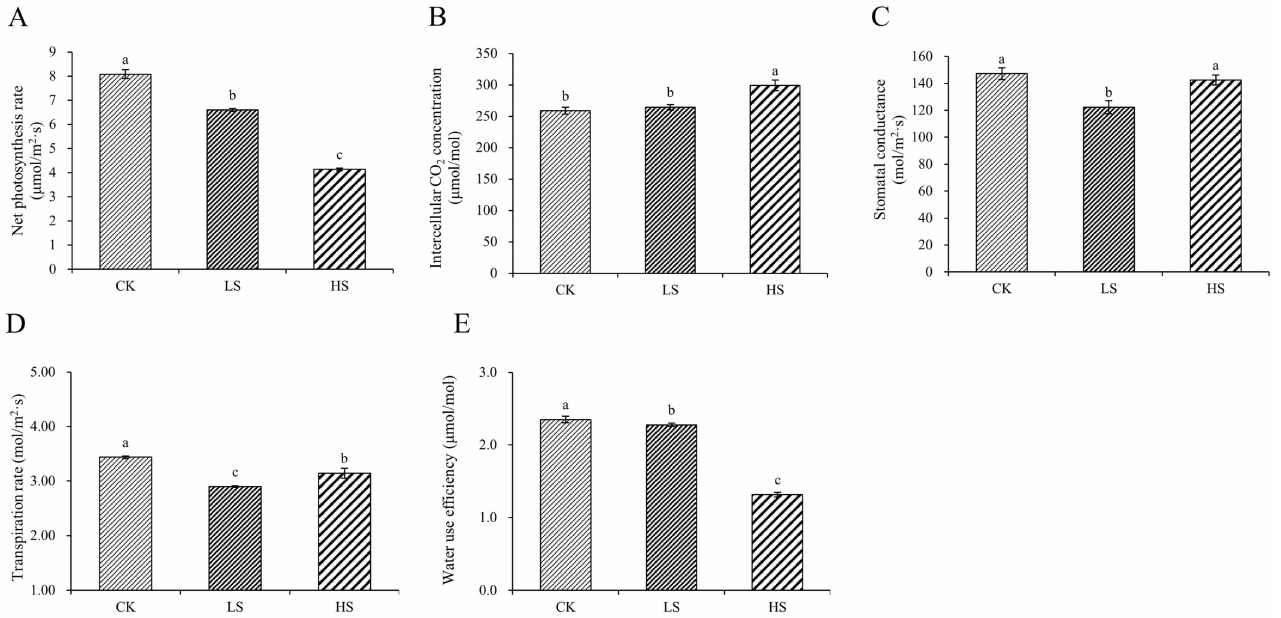
Figure 2. Changes in photosynthetic indicators in P. koraiensis under light stress. ( A ) Net photosyn- thetic rate. ( B ) Intercellular CO 2 concentration. ( C ) Stomatal conductance. ( D ) Transpiration rate. ( E ) Water use efficiency. CK: control. LS: light shade. HS: heavy shade. The error bars represent the standard error. Different letters indicate significant differences among different